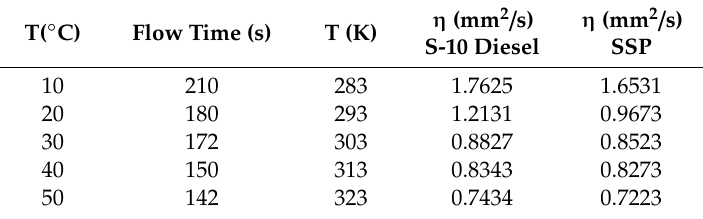
Table 6. Viscosity of SSP at di ff erent